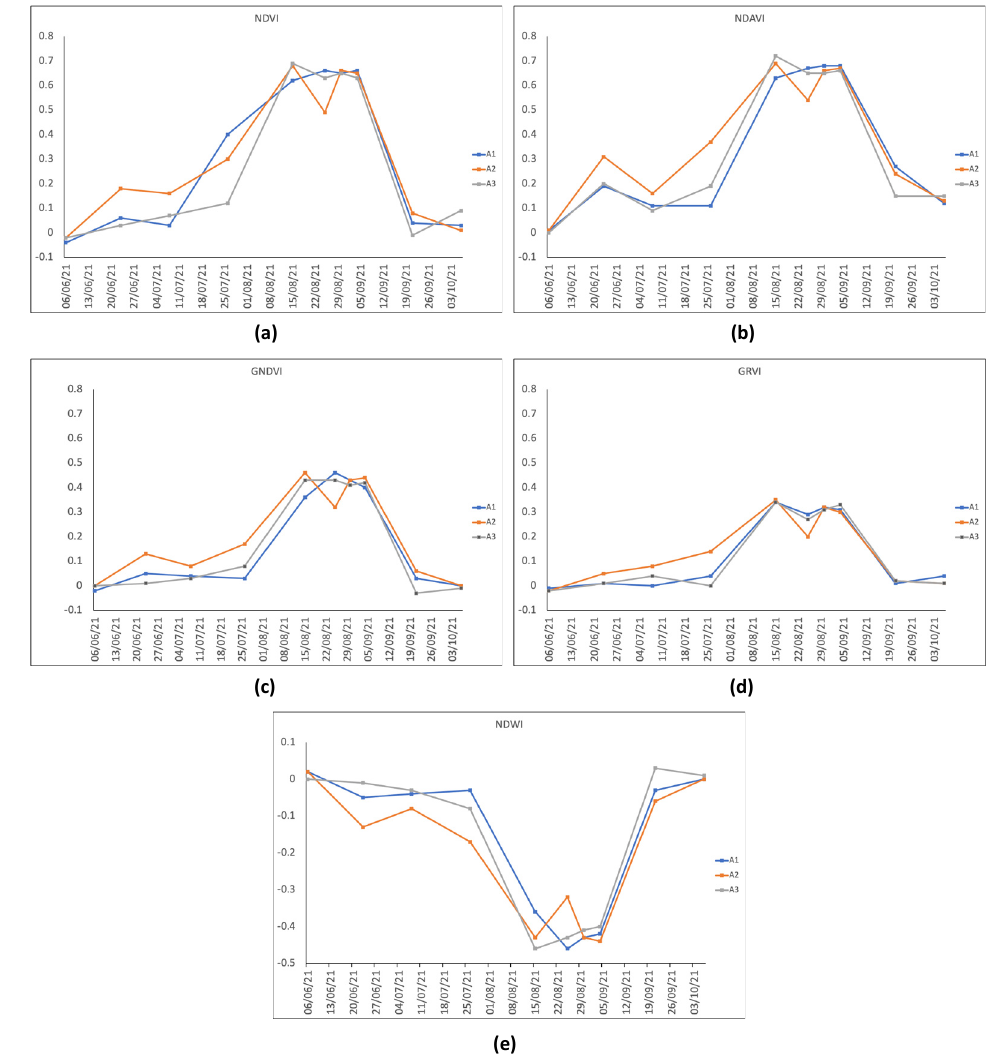
Figure 6. Temporal variation in Sentinel-2-based vegetation and water indices calculated for the three sample areas, A1, A2, and A3 (Figure 4a), defined on the water surface of a section of the Lis River infested with duckweeds, over a period of four months (6 June–6 October 2021): ( a ) NDVI, ( b ) NDAVI, ( c ) GNDVI, ( d ) GRVI, and ( e ) NDWI.